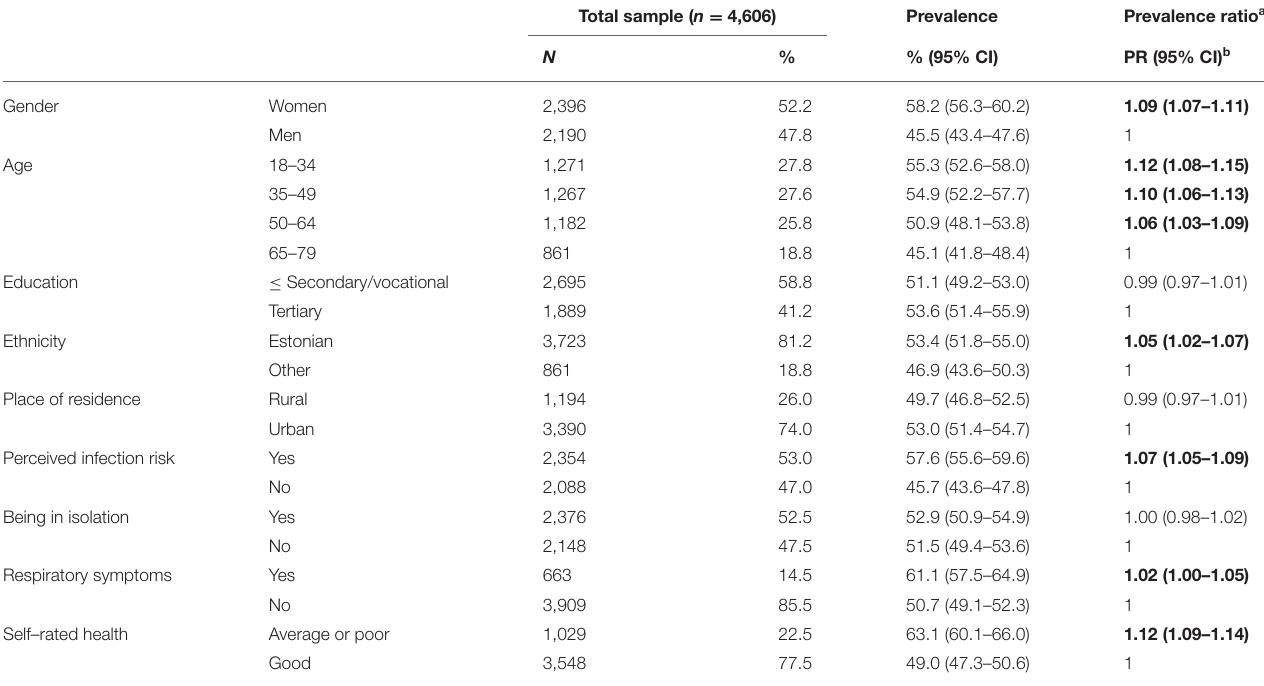
TABLE 1 | Prevalence rates and adjusted prevalence ratios with 95% confidence intervals for excessive